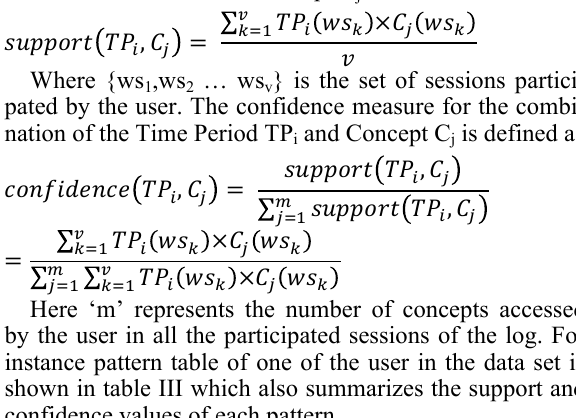
TABLE II. C ONTEXT TABLE OF A USER FOR FIVE WEB SESSIONS Web Session